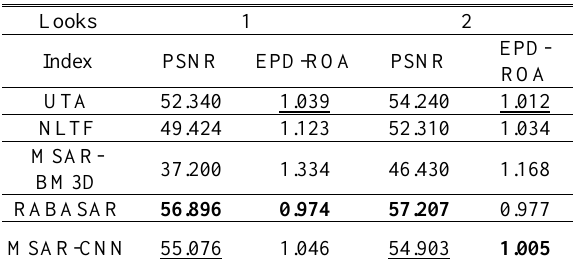
Table 2 Average quantitative assessment result of test dataset (16 simulated realistic SAR images) with single and two